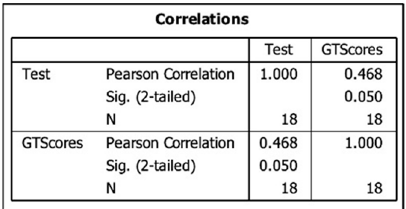
Figure 18. Bivariate correlations analysis on scores (GTs Test vs. scores using tools).